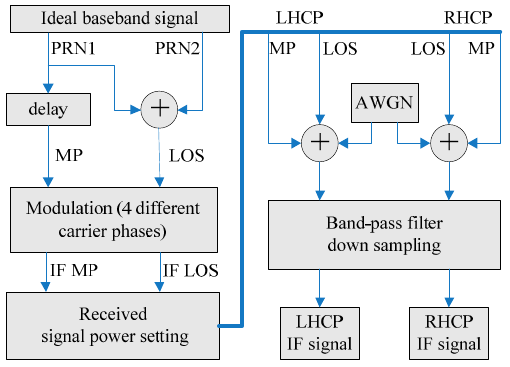
Figure 8. The diagram of the IF signal generator.